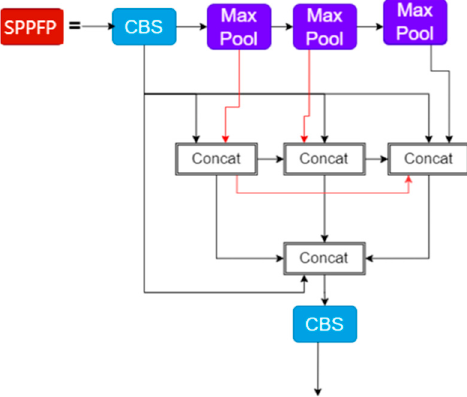
Figure 5. The structure of SPPFP.